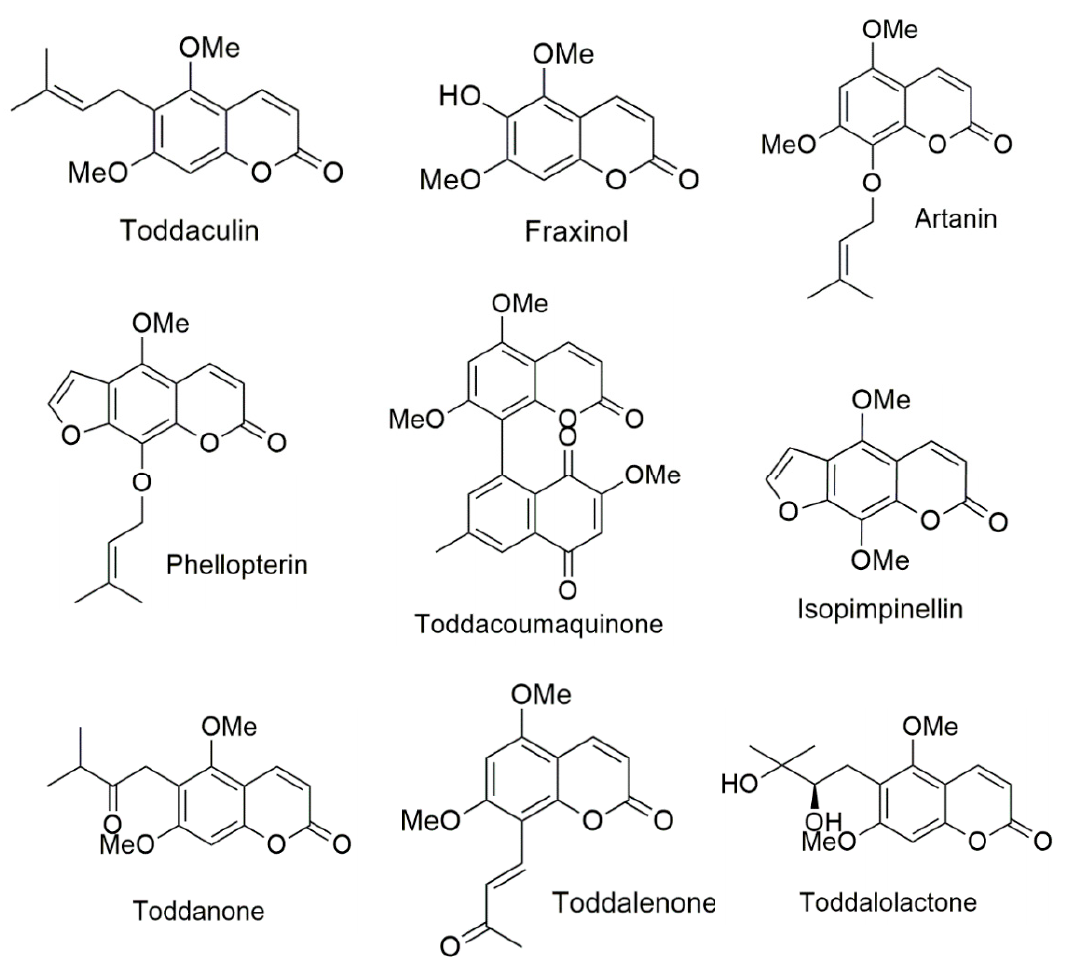
Figure 1. Structures of coumarin derivatives.